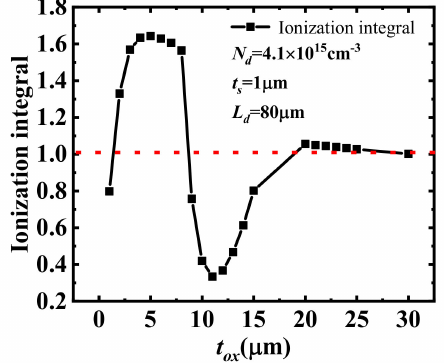
Figure 3. Variation curve of the ionization integral with t ox for the avalanche breakdown of lateral power devices. The red dashed line shows the trend value of the ionization integral when t ox increases to a certain